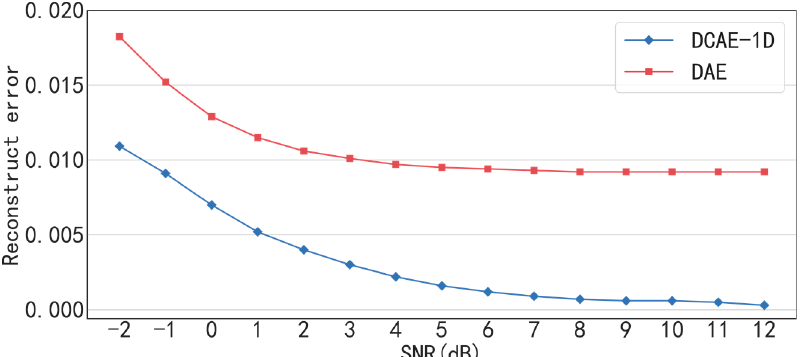
Figure 14. Reconstruction error of DCAE-1D and DAE under different SNR.